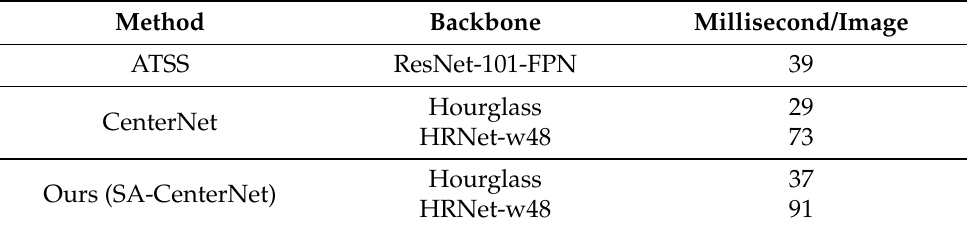
Table 9. The model’s inference speed on the KITTI dataset. The resolution of all the input images was set to be the same. All the models were tested on the same computing platform. The stack number of Hourglass was set to 1.